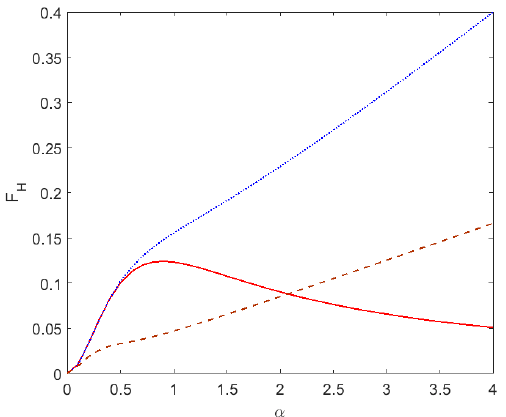
Figure 4. Dependence of Holtsmark function F H upon pulse duration parameter α for different values of dimensionless detuning δ : solid line − δ = 0, dotted line − δ = 0.5, dashed line − δ = 5. Figure 5 demonstrates the effect of pulse duration on the Holtsmark–Doppler generalized line ( ) F ΔΔ=ξδα ,, for different values of Doppler to Holtsmark line width ratios, ξ , and shape HDHD pulse durations, α . It is seen that the effect of the Doppler broadening produces a decrease of the dip in the center of the static Holtsmark line shape.